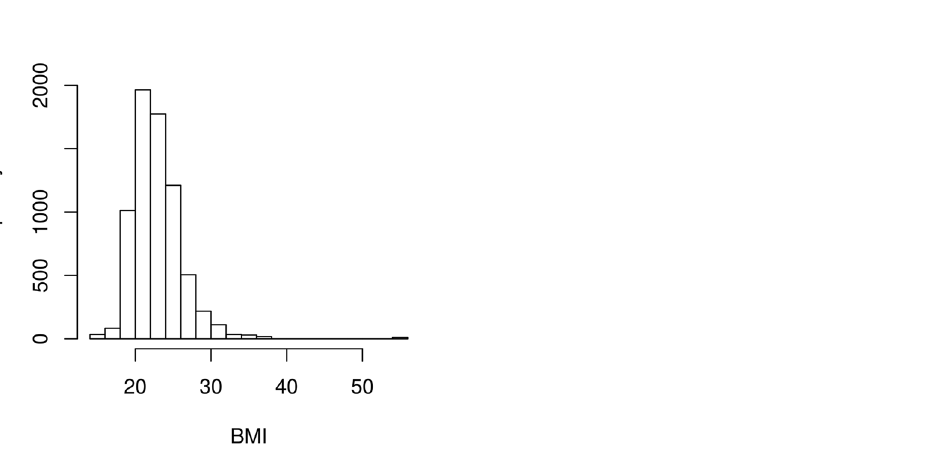
Figure 1. Histogram of Body Mass Index (BMI)